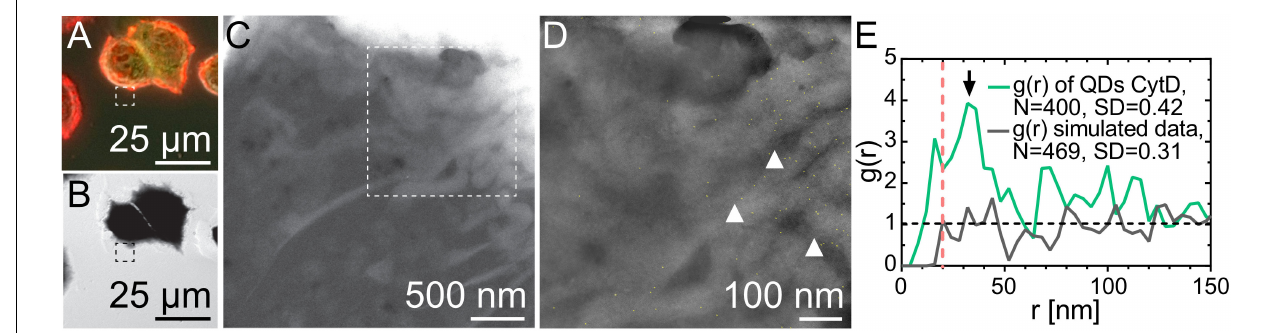
FIGURE 4 | Correlative FM and STEM of whole breast cancer cells treated with Cytochalasin D. (A) Cropped fluorescence micrograph of Cytochalasin D treated SKBR3 cells with actin-GFP in green, QD-labeled membrane ErbB2 in red and overlapping areas in yellow. (B,C) Corresponding STEM images of graphene-covered SKBR3 breast cancer cells ( M = B: 1000 × , C: 30,000 × ). (D) Cytochalasin D inducedindentations are marked exemplarily with white arrowheads. STEM image of region enclosed with dashed square in A ( M = 100,000 × ). Automatically detected QD-labels are marked in yellow to enhance visibility. (E) g ( r ) of QD-labels collected in seven images of cell edges of Cytochalasin D treated cells. The arrow marks a peak at r = 36 nm, and the dotted line indicates r = 20 nm. g ( r ) of simulated data of randomly positioned labels.